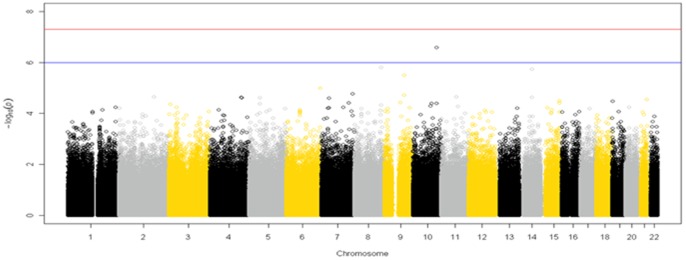
Genome-wide association results for T2D in African Americans from VGER/NUgene.We performed single SNP test of association with >930K SNPs across the genome using logistic regression in 736 T2D cases and 827 controls. The red line indicates the genome-wide significance level p<10−8 and the blue line is indicate of suggestive associations at p<10−6.